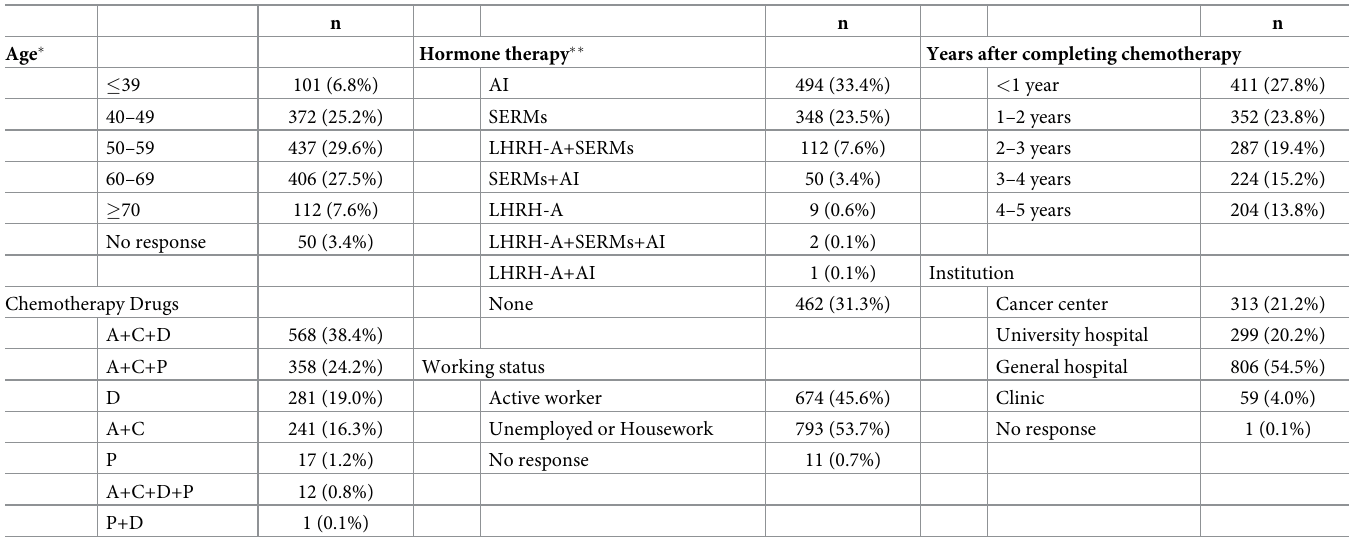
Table 1. Patient characteristics (n =